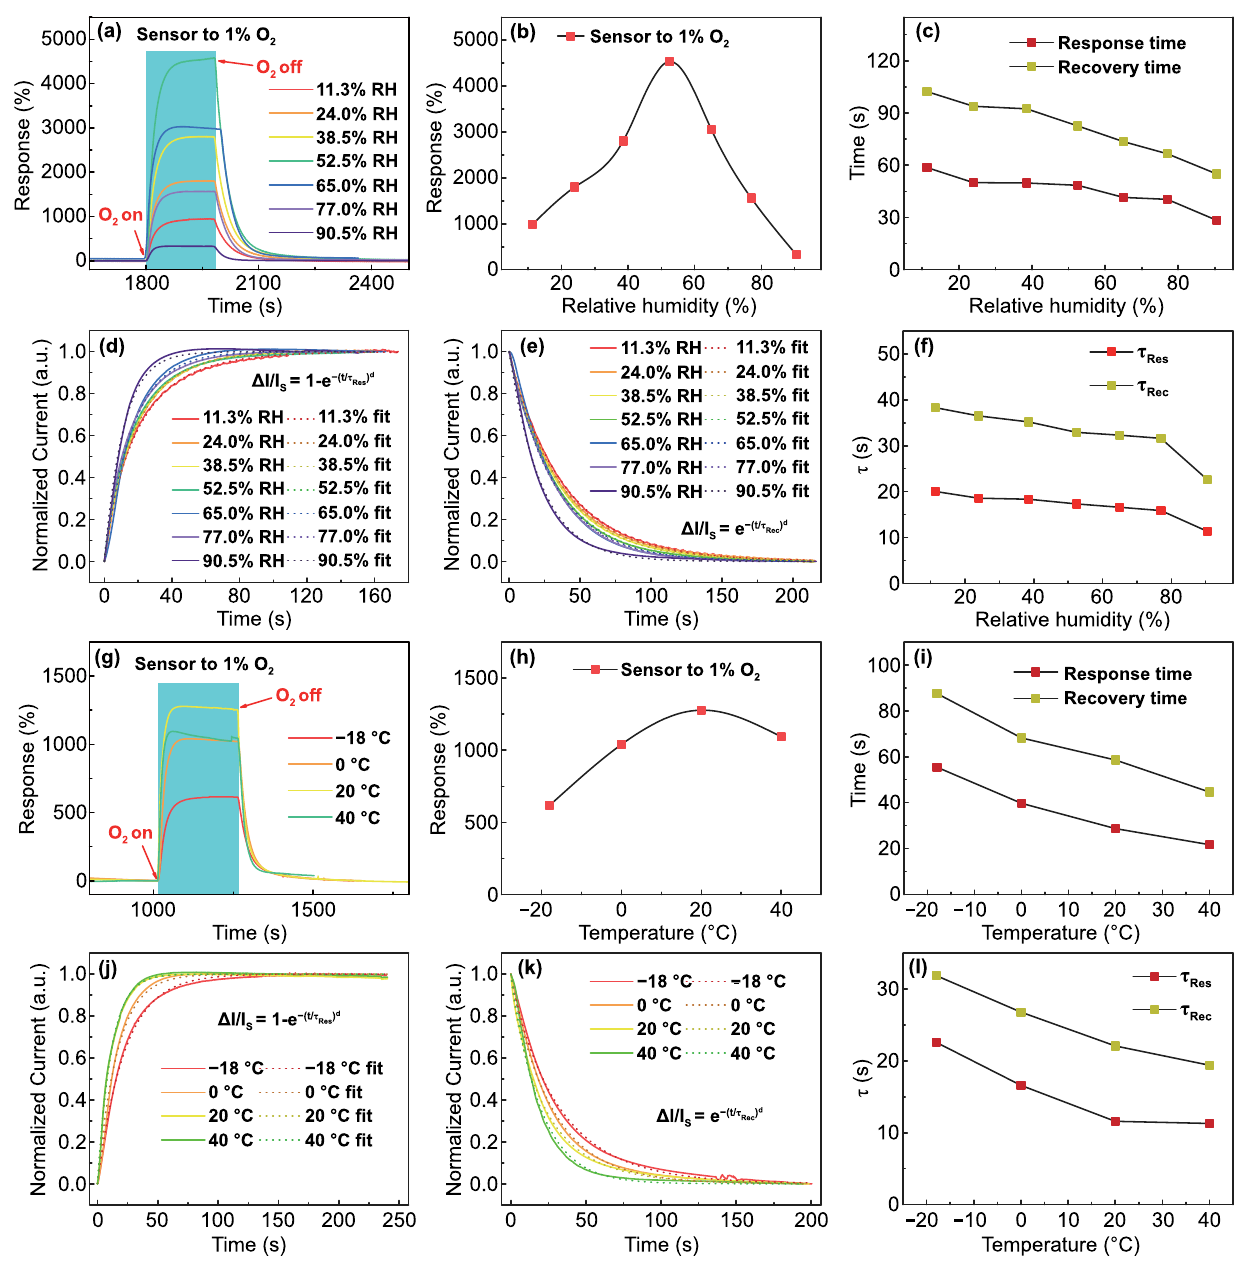
Fig. 5 Influences of humidity and temperature on O 2 sensing properties of organohydrogel sensor. a Dynamic response curves to 1% O 2 under 11.3%, 24.0%, 38.5%, 52.5%, 65.0%, 77.0%, and 90.5% RH. b Response extracted from a versus relative humidity. c Response and recovery time t 90 extracted from a versus relative humidity. d and e Normalized current variations in response to 1% O 2 under different RH with fits to the exponential growth formula in the response and recovery processes, respectively. f Plots of time constants ( τ Res and τ Rec ) versus relative humid- ity. g Dynamic response curves to 1% O 2 at -18, 0, 20, and 40 ℃ . h Response extracted from g versus temperature. i Response and recovery time t 90 extracted from g versus temperature. j and k Normalized current variations in response to 1% O 2 under different temperatures with fits to the exponential growth formula in the response and recovery processes, respectively. l Plots of time constants ( τ Res and τ Rec ) versus